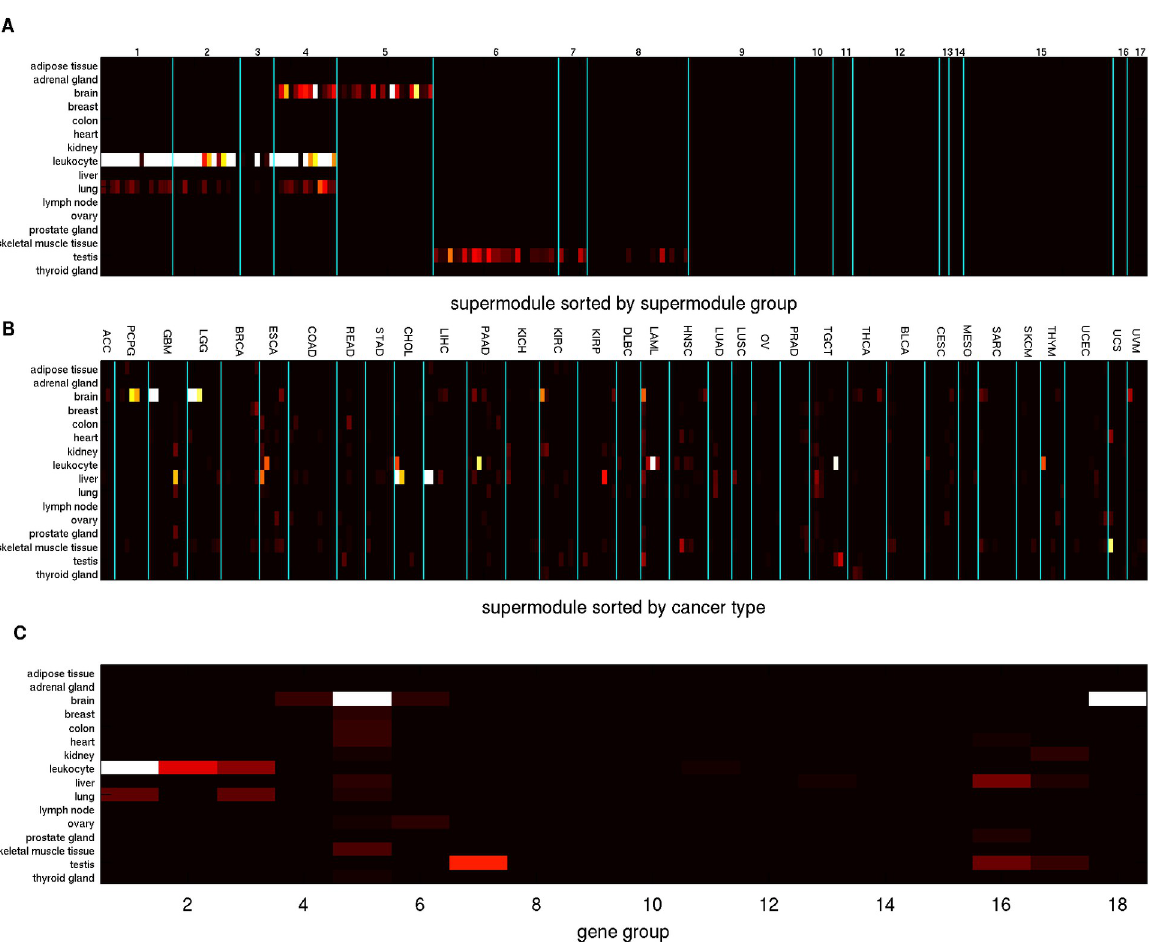
Fig 10. Enrichment p-values of tissue-specific genes derived from the Illumina Bodymap data in Super Modules sorted by A : Super Module Groups, B : cancer types, and in C : Gene Groups. Enrichment p-values of Super Modules and Gene Groups are reported in S11C and S11D Table.